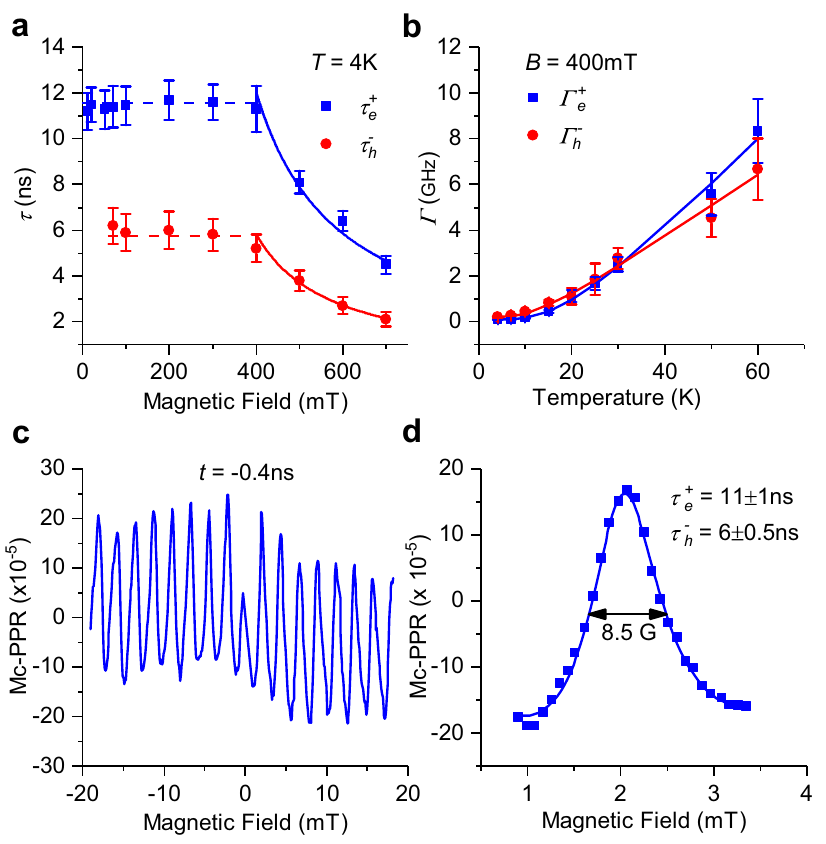
Fig. 7 Magnetic fi eld and temperature dependencies of the spin dynamics in MAPbI 3 single crystal measured on (100) facet with B // [001]. a Magnetic- fi eld dependence of the spin-decay time, τ ( B ) for the T + and T − species ( τ þ ; (cid:3) mean-square fi t of the c-PPR dynamics in Fig. 2 and Supplementary Fig. 9 using Eq. (2). b Temperature dependence of the spin-decay rate Γ þ ; (cid:3)ð Þ T + and T − species measured at B = 400 mT. Error bars derived from the least mean-square fi t of the c-PPR dynamics in Supplementary Fig. 12 using